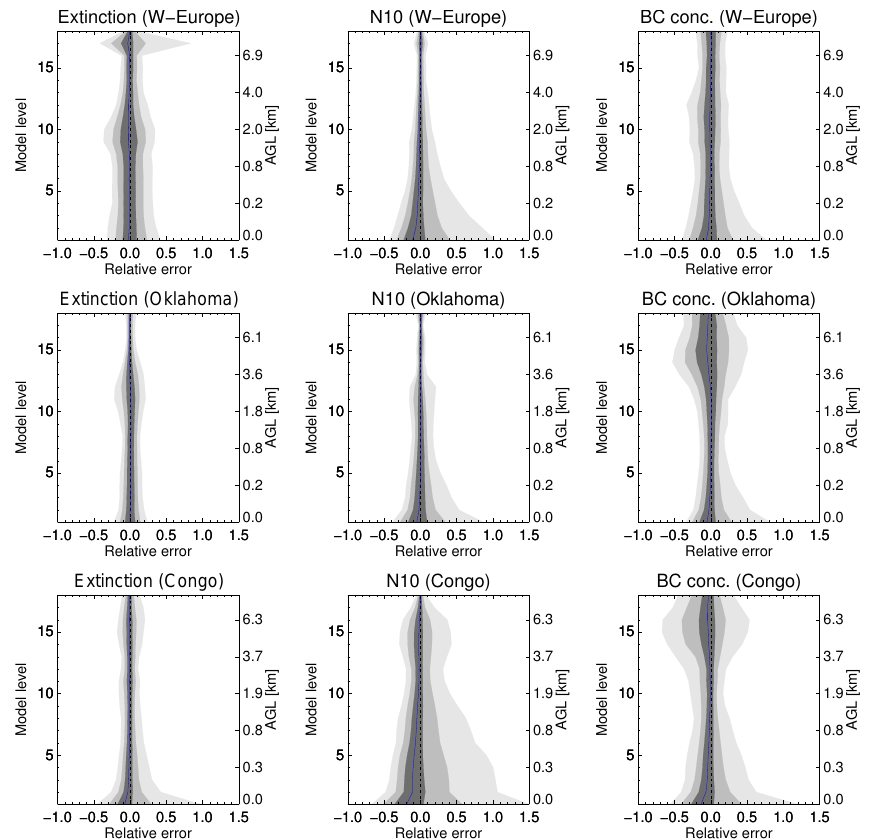
Figure 11. Relative spatial sampling error (monthly data) as a function of model level (left vertical axis) and altitude above ground level (a.g.l., right vertical axis) for extinction, N10 and black carbon concentrations. Results for the WRF-Chem MADE simulations. Further explanation in Sect. 3.2.